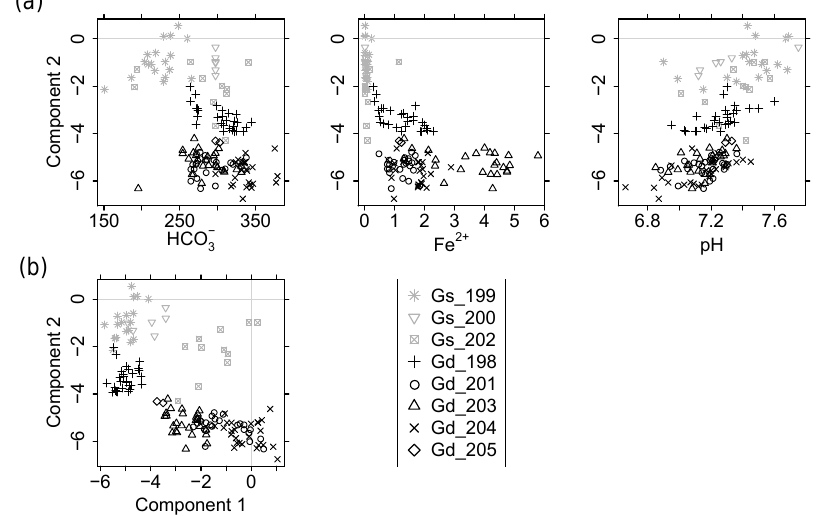
Figure 4. (a) Selection of variables versus scores of component 2 for the groundwater samples. Concentration in mgL − 1 . (b) Scores of component 1 versus component 2 at the groundwater